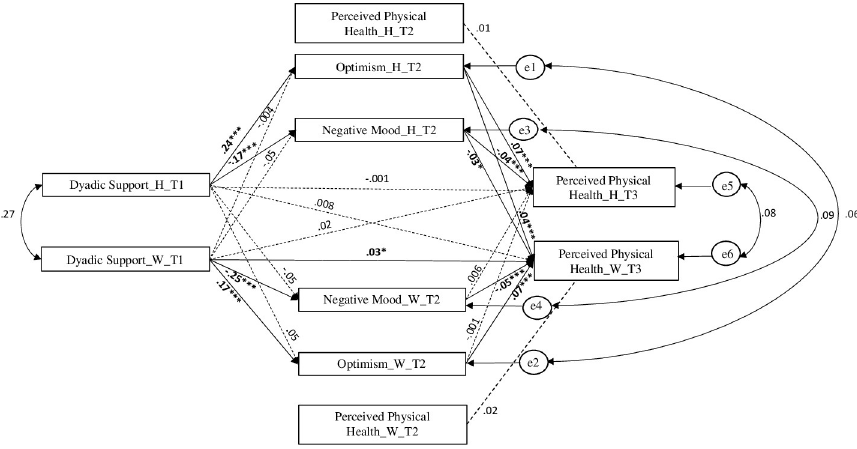
Fig 2. APIMeM with husbands’ and wives’ social support as predictor variables. Note : H = husband; W = wife. Plain lines showed the significant paths, dotted lines the non-significant paths. � p < .05, �� p < .01, ��� p < .001. Data Source: Swiss Household Panel